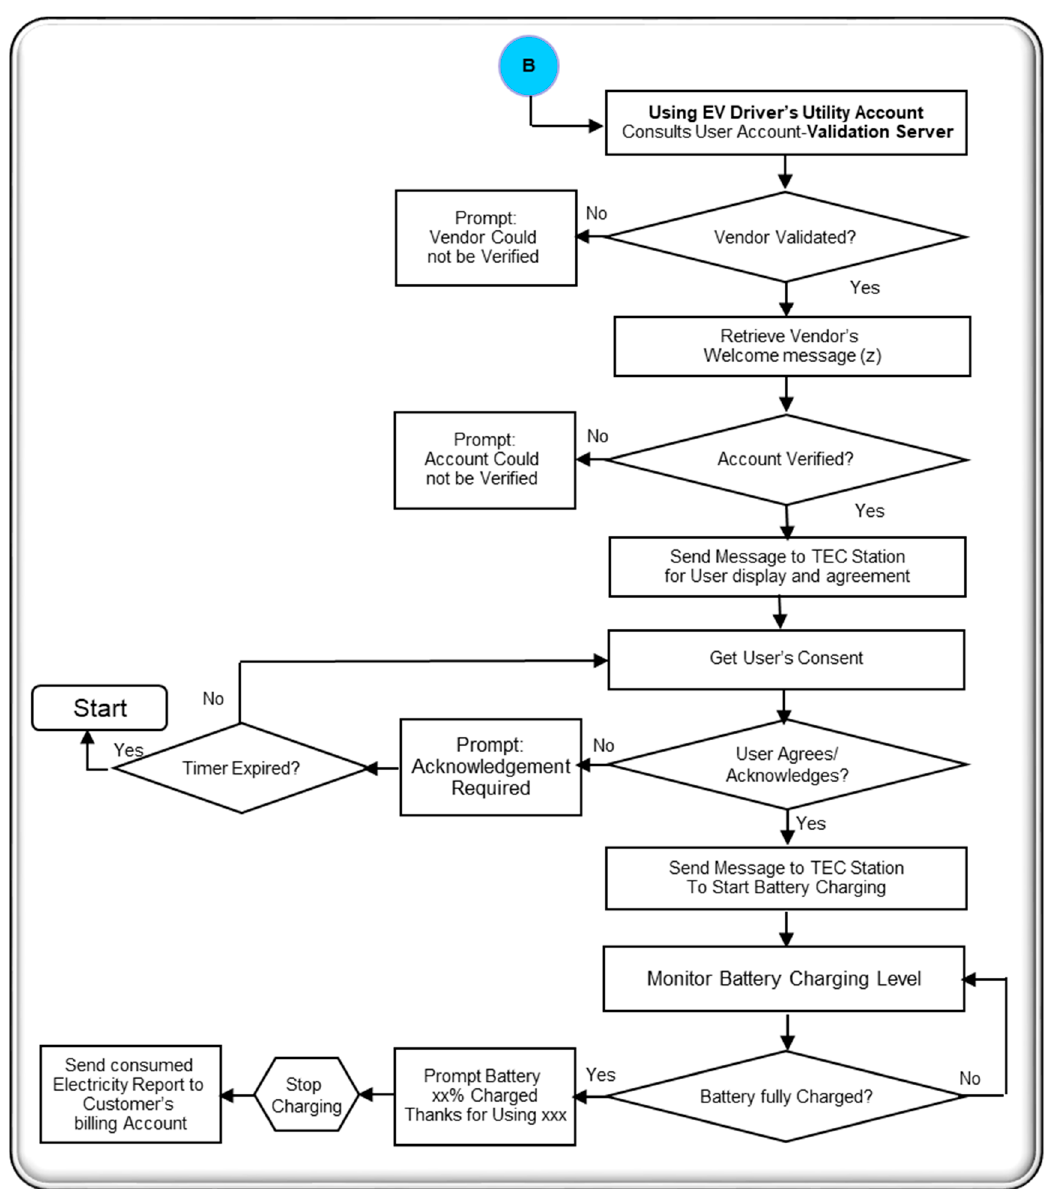
Figure 4. TEC (Toll-Free EV Charging) service provisioning Type-2 (consumer pays).